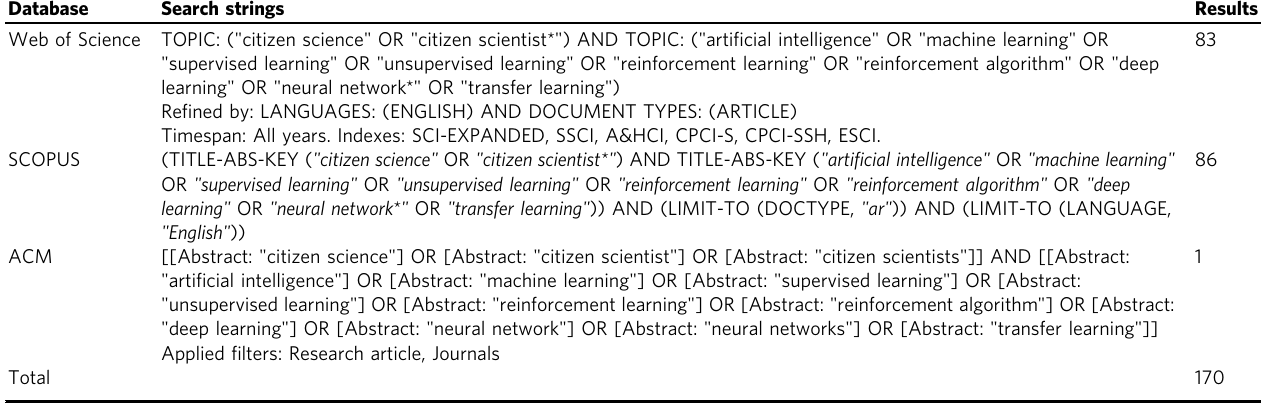
Table 1 Search procedure 1. Database Search strings Results